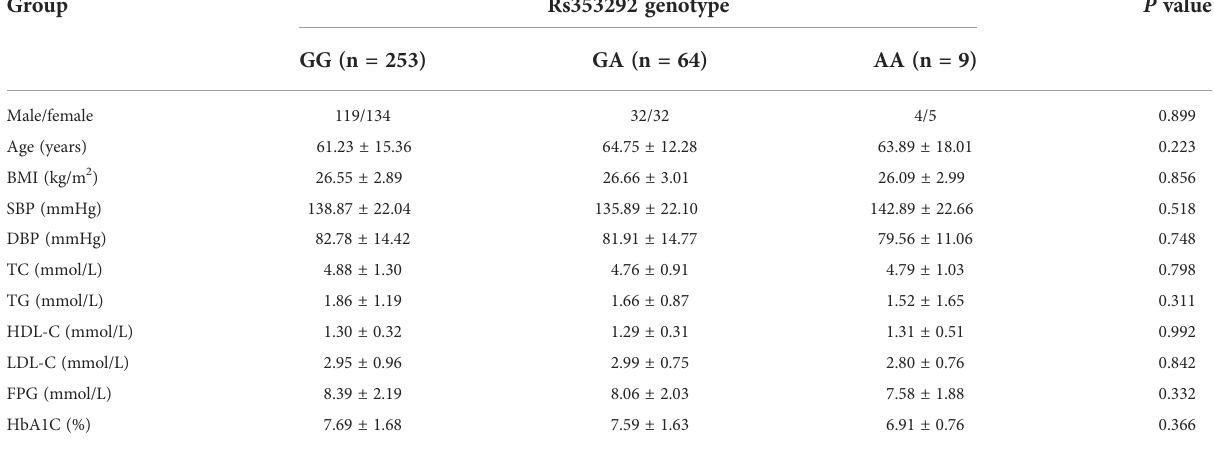
TABLE 4 Association between the rs353292 genotypes and clinical characteristics of T2DM patients. Group